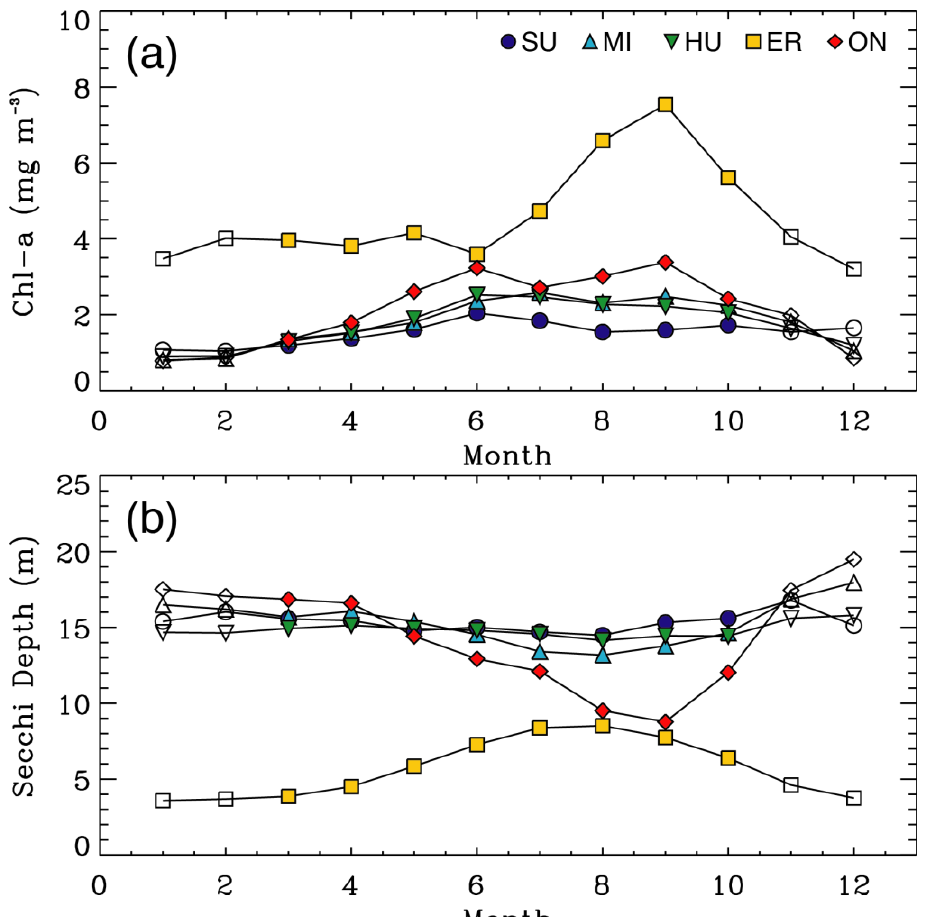
Figure 8. Comparisons of VIIRS-SNPP-derived climatology (2012–2019) monthly means of ( a ) Chl-a and ( b ) SD, for Lake Superior (SU) (blue), Lake Michigan (MI) (light blue), Lake Huron (HU) (green), Lake Erie (ER) (yellow), and Lake Ontario (ON) (red). Note that the filled symbols highlight the non-winter months (March–October).